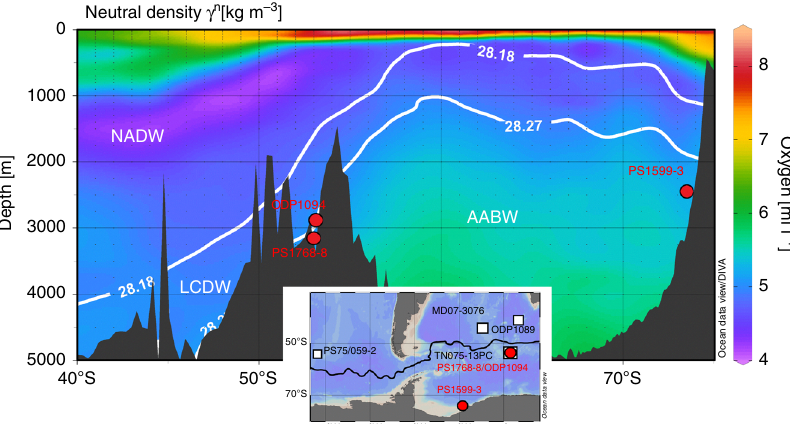
Fig. 1 Studied sediment core sites. Color-mapped oxygen concentrations, with neutral density contours ( γ n ) overlain, as drawn from the 2013 World Ocean Atlas 69,70 . Sediment cores presented here (ODP Site 1094, PS1768-8 and PS1599-3) are marked with red circles. The locations of other cores mentioned in the text are marked as white squares in the inlet map. The isopycnal with a neutral density of 28.27kg m − 3 de fi nes the water mass boundary between AABW and LCDW, while the 28.18 kg m − 3 isopycnal de fi nes the top of Antarctic Circumpolar Current bottom water as de fi ned in Orsi et al. 18 . Figure created with Ocean Data View 71 . AABW: Antarctic Bottom Water; LCDW: Lower Circumpolar Deep Water; NADW: North Atlantic Deep